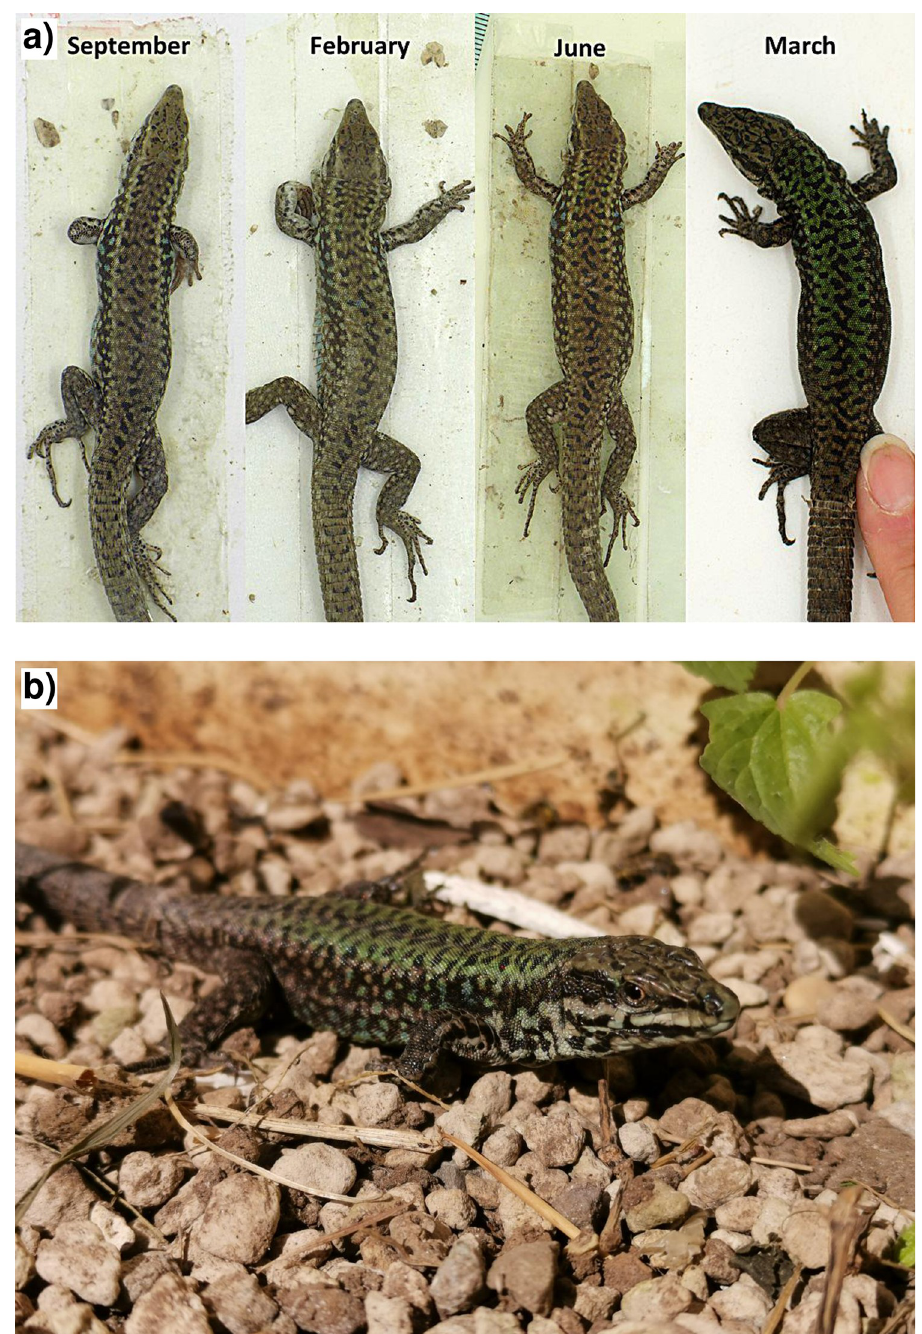
Fig 5. Phenotypes of one captive male Podarcis raffonei in different months (photos by L.